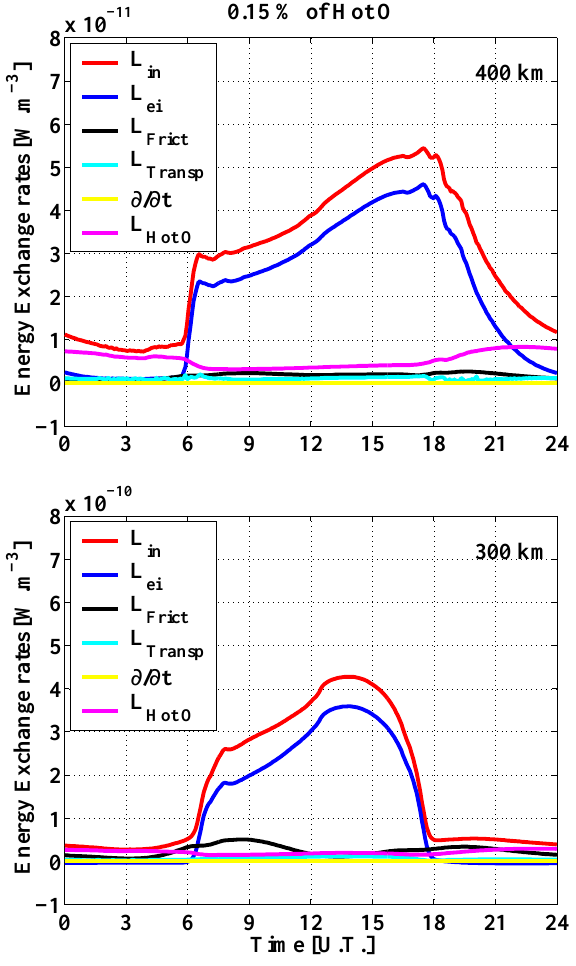
Fig. 5. Same as Fig. 3, but a population of hot O has been added to the standard MSIS neutral atmosphere: Hot O concentration is kept constant vs. time such that at noon { n [ O Hot ] /n [ O ]} 400km = 0 . 15%; its altitude profile is defined with an equivalent exospheric temper- ature of 4000 K. However, n [O] and T ∞ fits are done ignoring the presence of this minor neutral